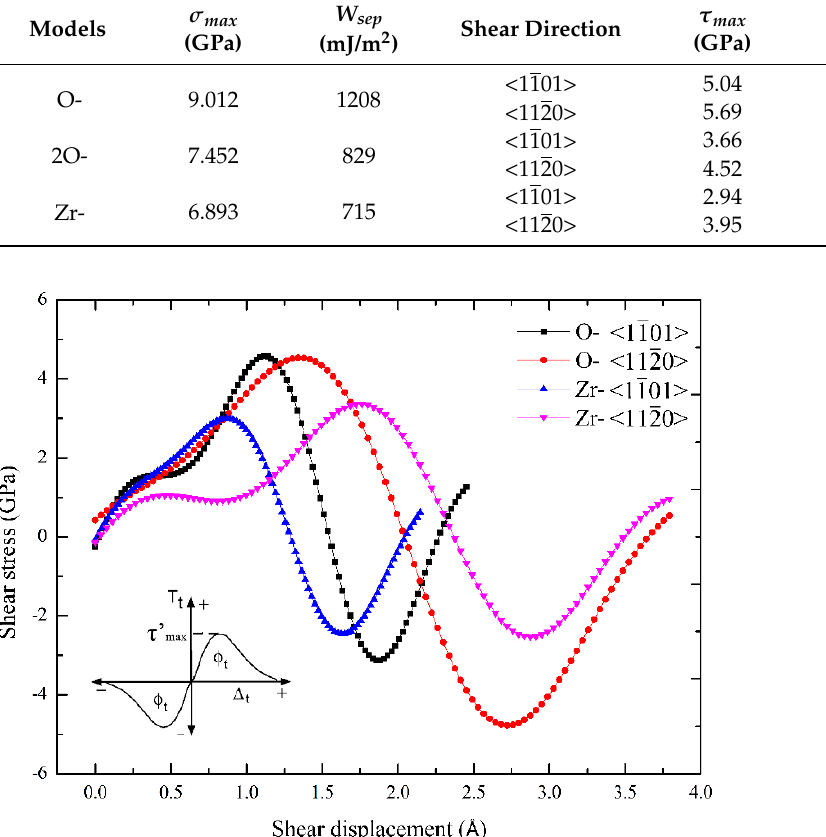
Figure 5. The shear stress–displacement curves of the c-ZrO 2 (001)/ α -Al 2 O 3 (1102) interface models fitted by the Fourier series.